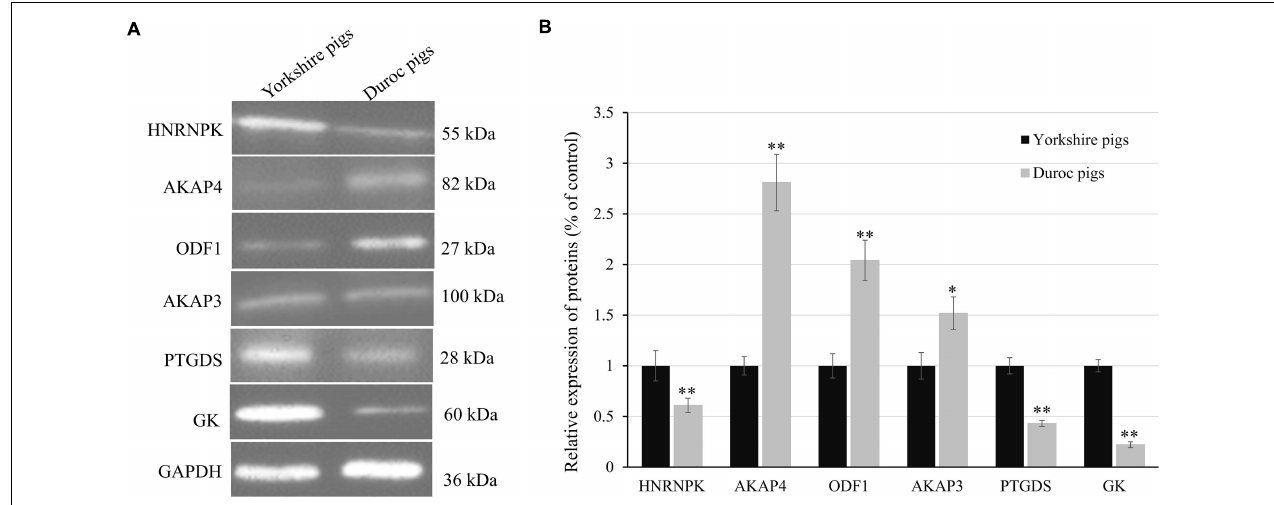
FIGURE 9 | Confirmation of differential expression of proteins between Yorkshire and Duroc boar spermatozoa. (A) Expression levels of HNRNPK, AKAP4, ODF1, AKAP3, PTGDS, and GK in Yorkshire and Duroc boar spermatozoa were confirmed by Western blotting. GAPDH served as a loading control. (B) Quantified relative band intensity ratio of (A) . * p < 0.05, ** p <